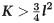
The channel's total profit with α in K>34l2.